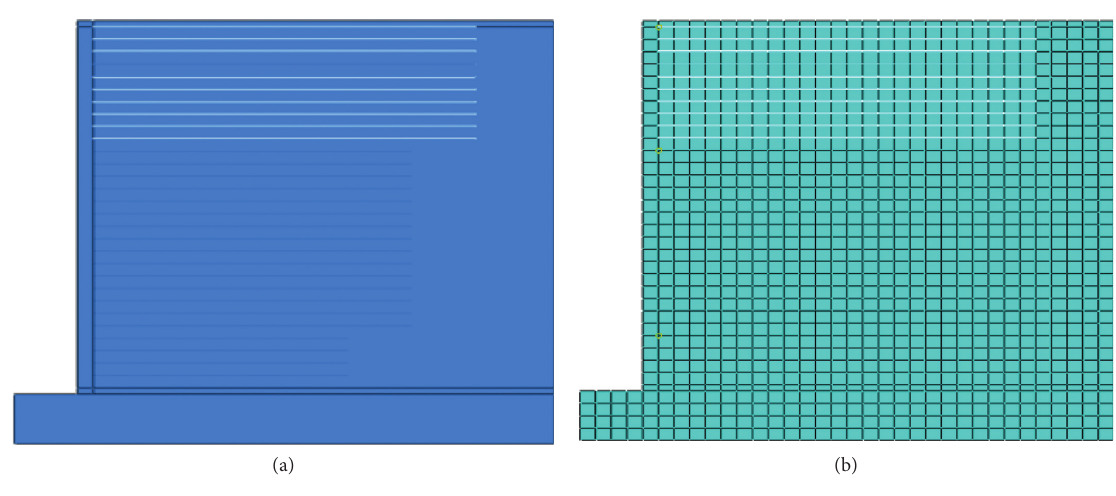
Figure 1: Retaining wall model and finite element